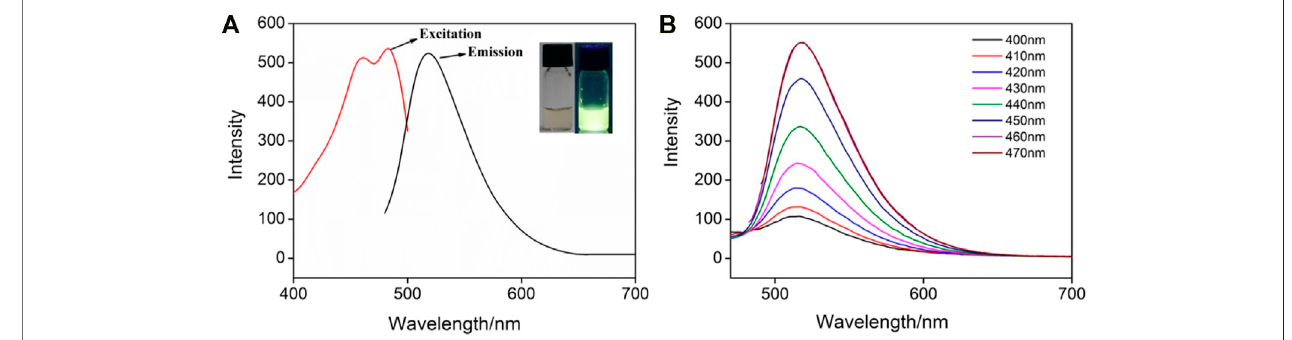
FIGURE4|(A) Fluorescence(FL) excitation andemissionspectraofIL-GQDs. Insets present thephotographs ofsolutionsundervisible (left) or365nmUV (right) light. (B) FL emission spectra of IL-GQDs under different excitation